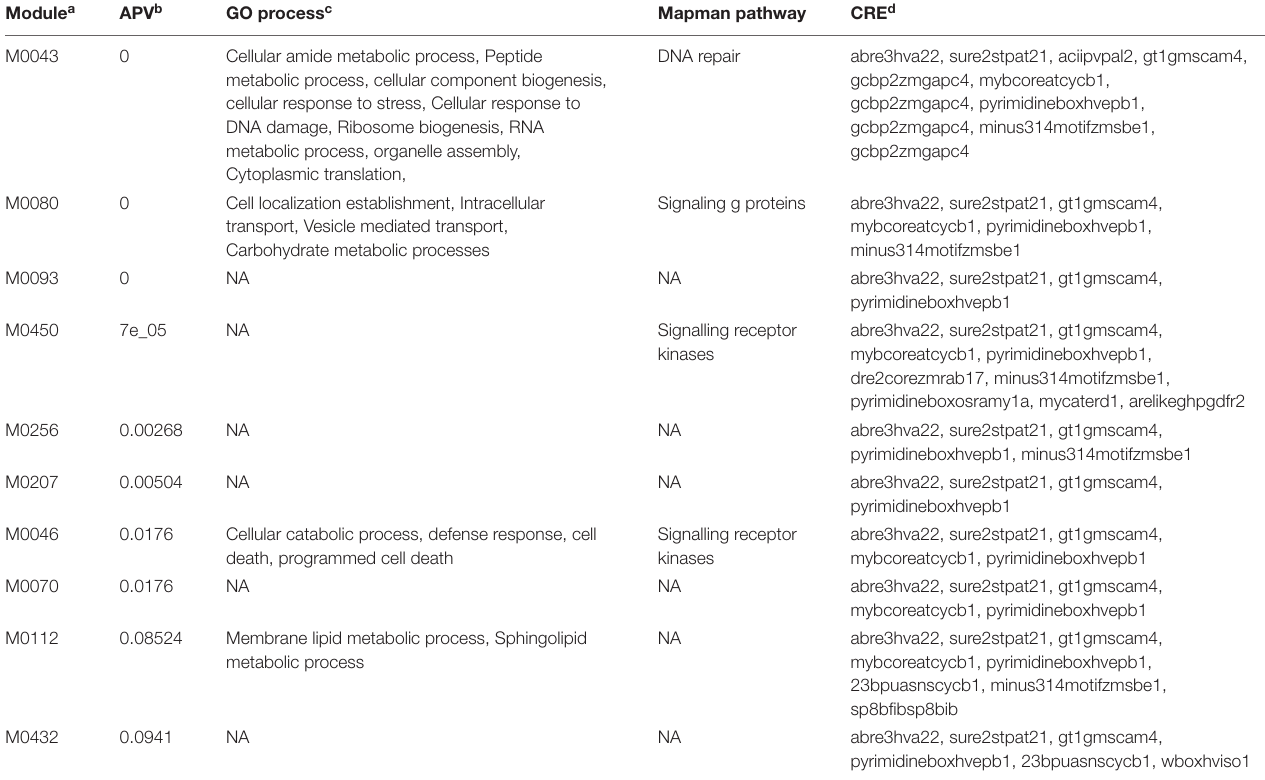
TABLE 4 | Gene ontology enrichment analysis of top 200 putative candidate genes identified using significant GWAS SNPs ( p < 0.001) associated with number of spiekelets in the panel under HNT stress. Module a APV